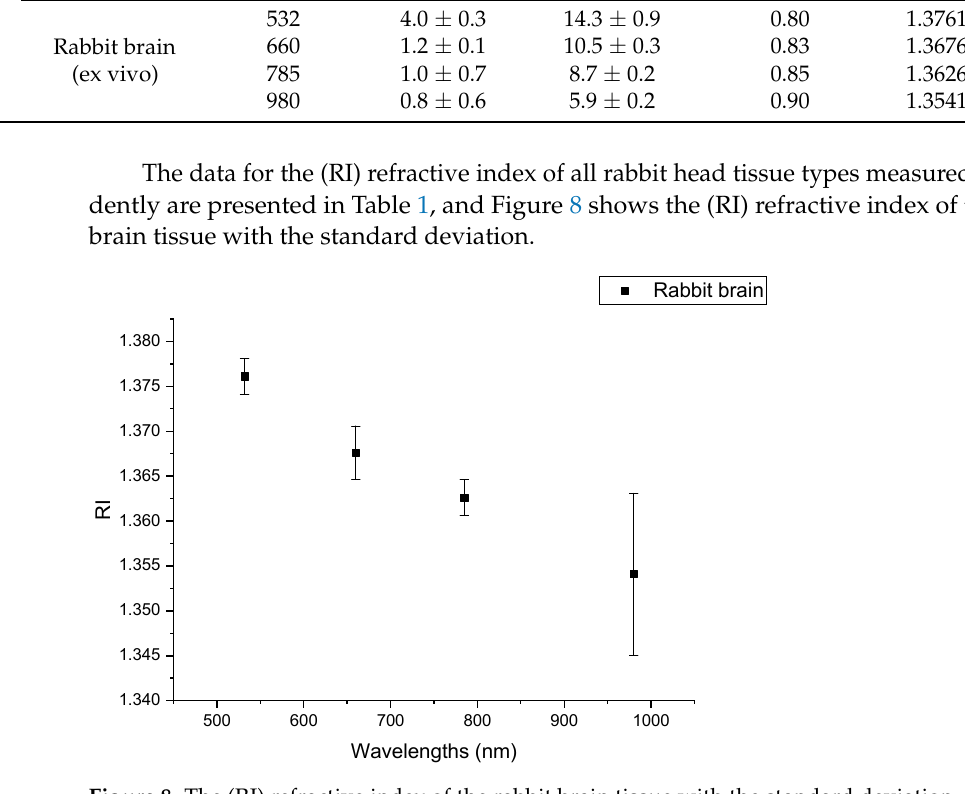
Figure 8. The (RI) refractive index of the rabbit brain tissue with the standard deviation. The data for the (RI) refractive index compared with the data from the literature are presented in Figure 9.